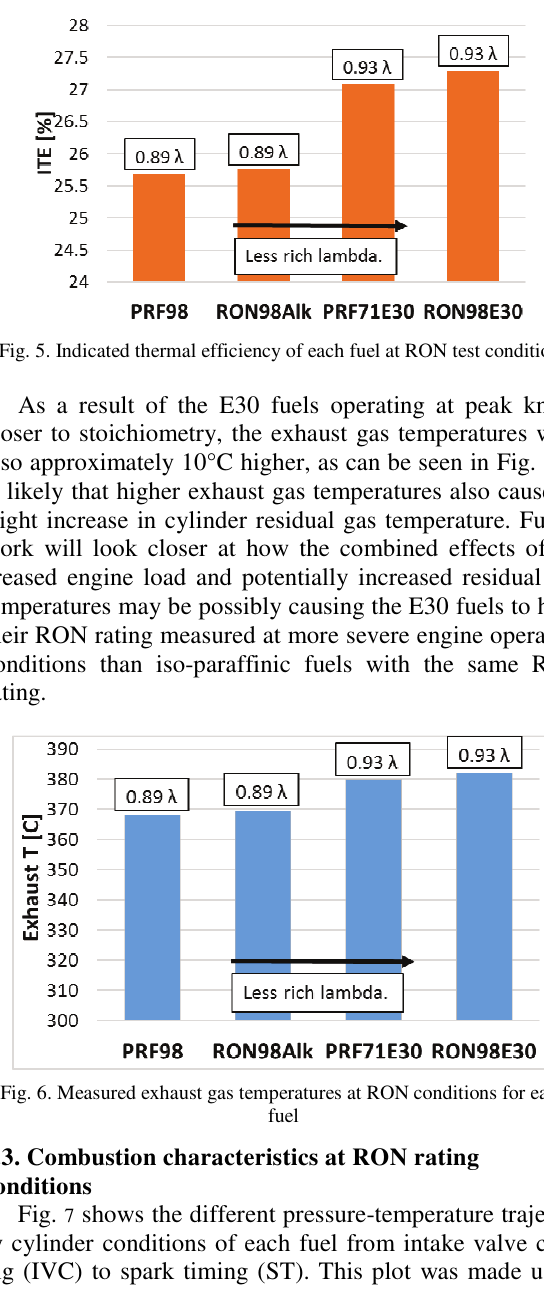
Fig. 4. Effect of fuel properties on engine load during RON testing